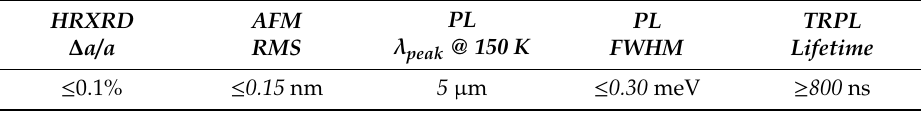
Table 1. Structural and optical criteria used to evaluate Ga-free T2SL structures grown by MBE.